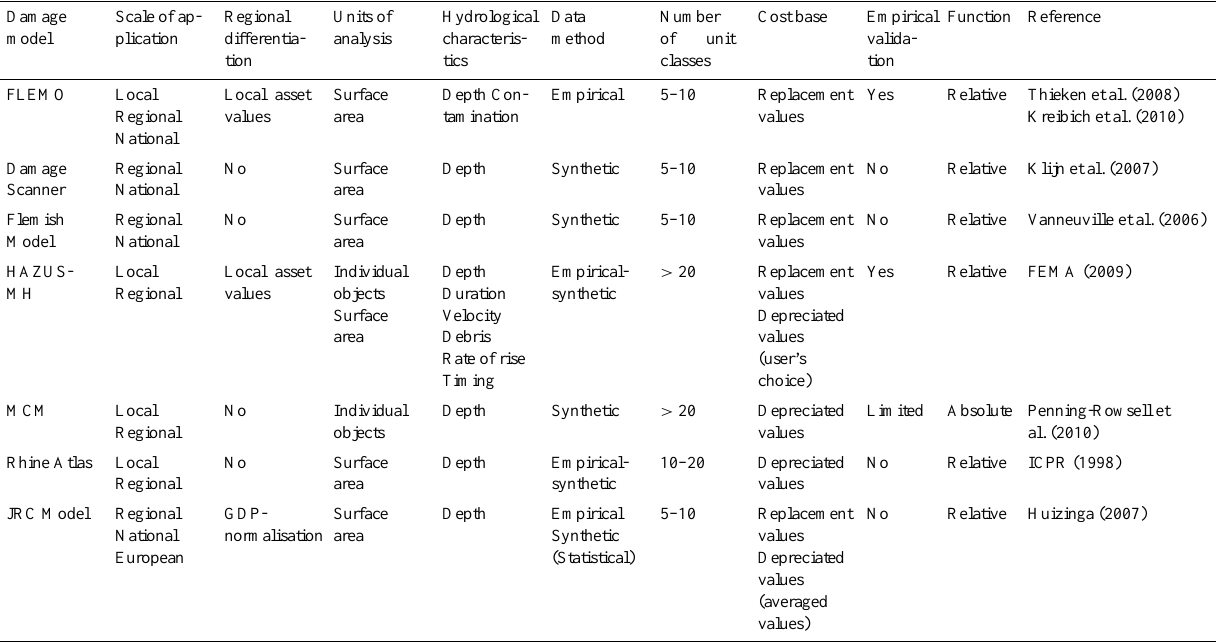
Table 3. Qualitative properties of the damage models included in this study, relating to their calculation of losses to residential, commercial and industrial units. A more extensive description of the models is provided in Sect.